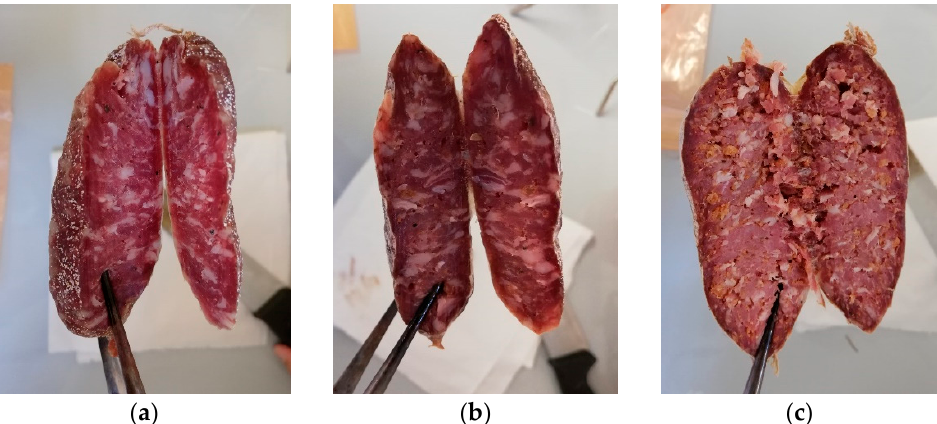
Figure 1. Pictures of the samples at 11-day ripening. ( a ) C, control (no added AP, 0%); ( b ) 7% AP, salami with 7% added AP; ( c ) 14% AP, salami with 14% added